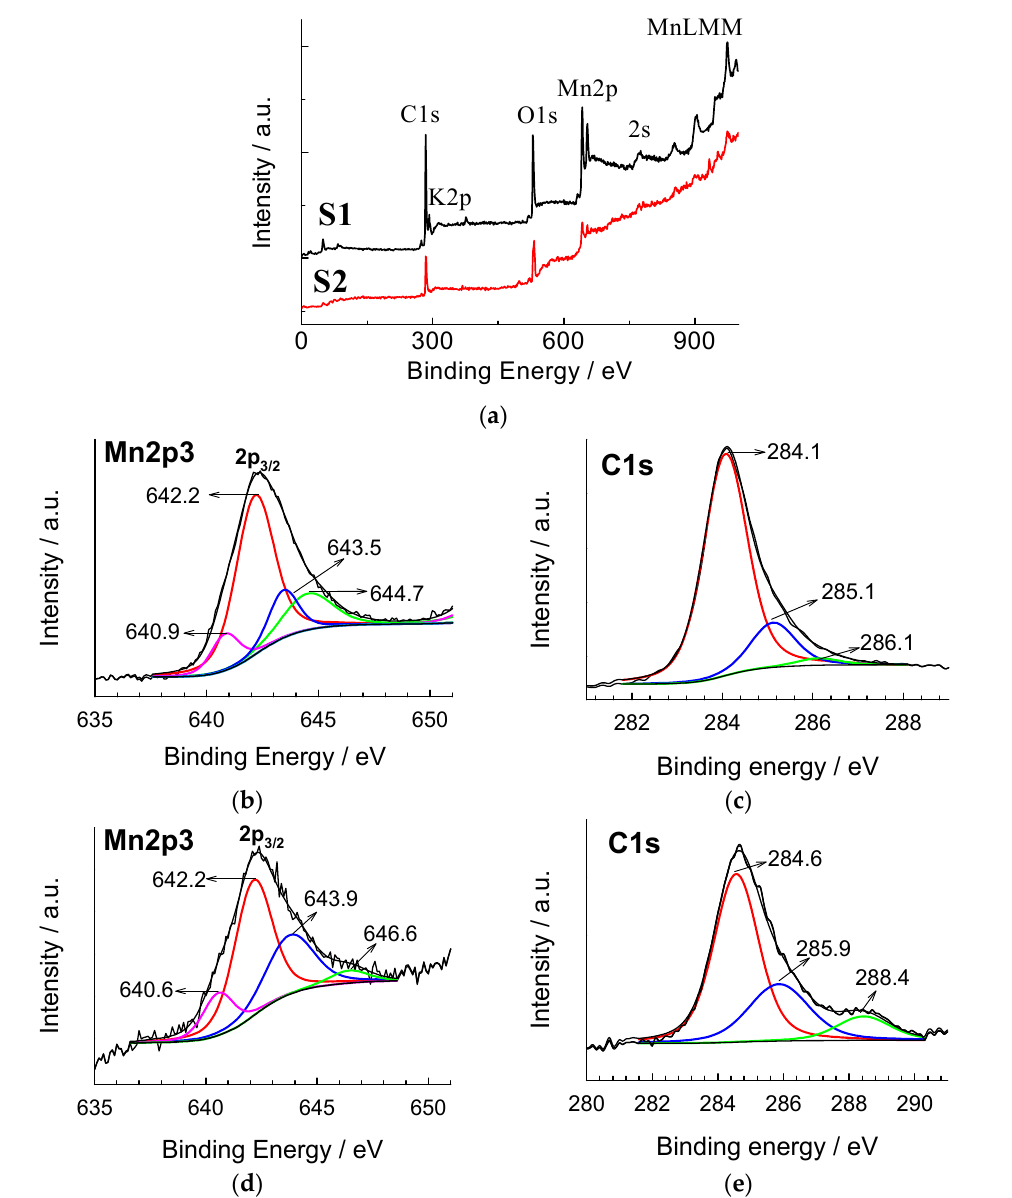
Figure 3. Survey spectra for samples S1 and S2 ( a ). XPS spectra of Mn 2p and C 1s for MnO 2 /C: ( b,c ) sample S1; ( d,e ) sample S2.